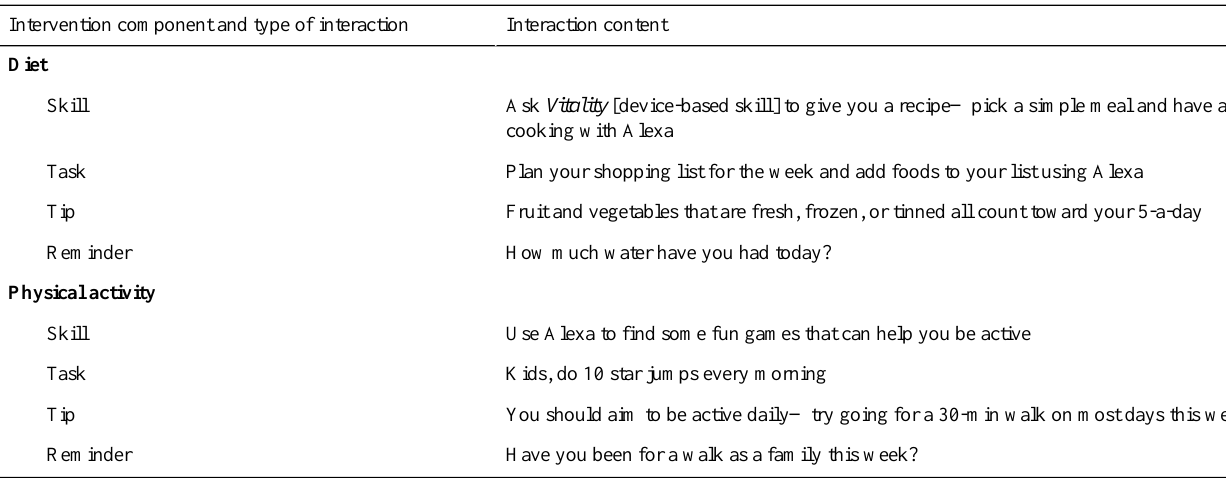
Table 1. Examples of intervention components delivered by the intelligent personal system.